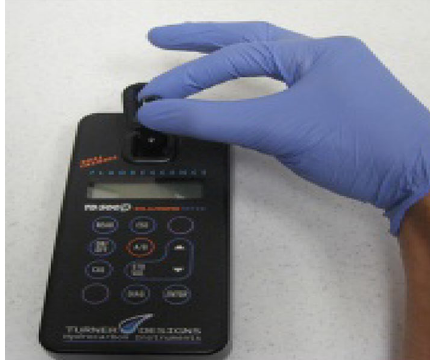
Fig. 2 TD-500D Oil in Water Analyser